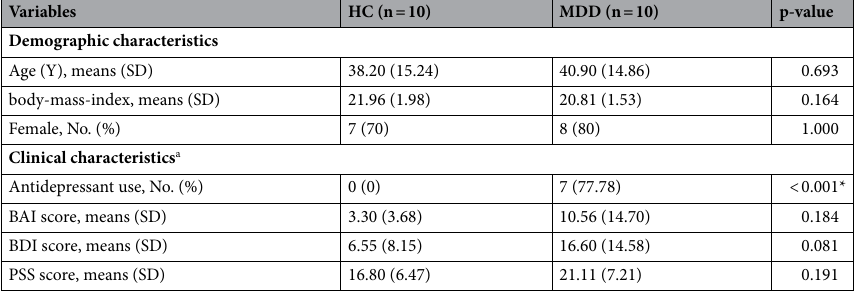
Table 1. Clinical characteristics of the subjects. HC healthy controls, MDD major depressive disorder, Age (Y) Years of age; Body mass index (kg/m 2 ), BDI Beck Depression Inventory, BAI Beck Anxiety Inventory, PSS Perceived Stress Scale. a One MDD subject had missing data in antidepressant use and clinical